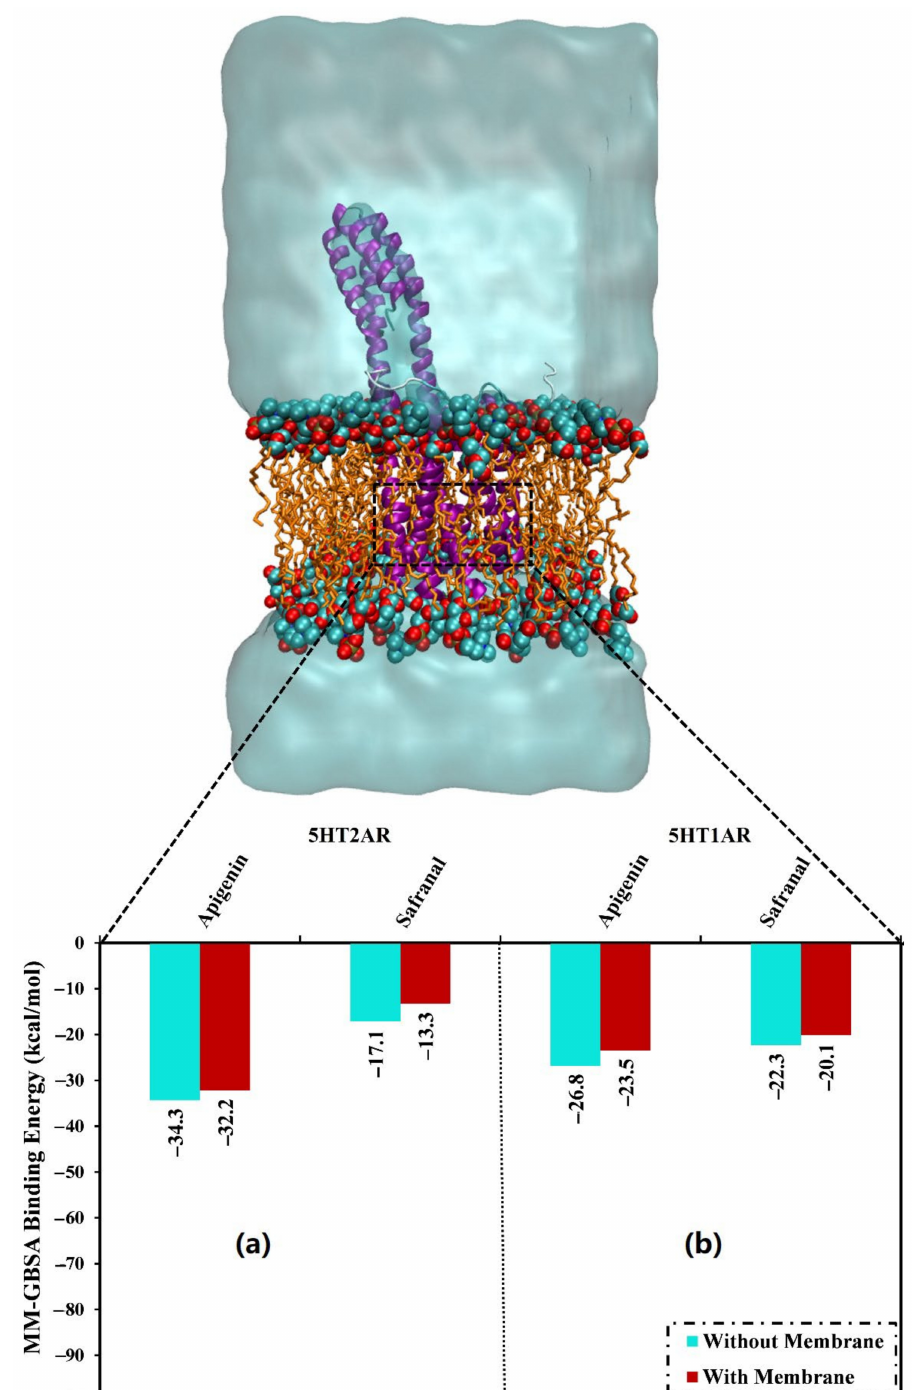
Figure 10. Binding affinities of the inspected apigenin and safranal with the ( a ) 5HT2AR and ( b ) 5HT1AR in the absence and presence of the POPC bilayer membrane over 200 ns MD